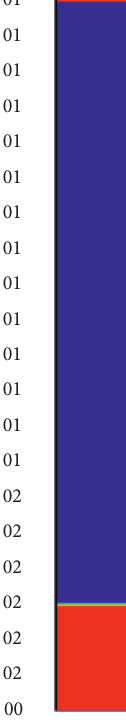
Figure 4: Initial state particle volume